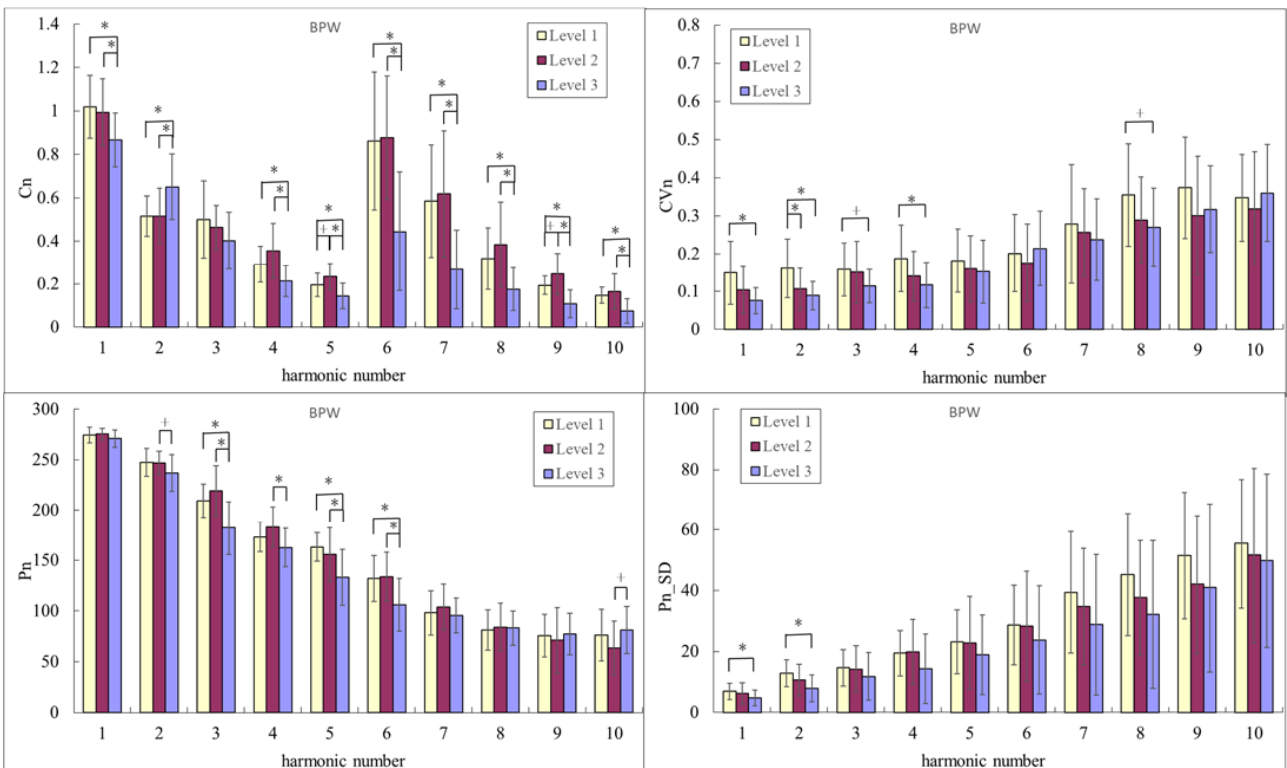
Figure 4. Comparisons of BPW harmonic indices between Level 3, Level 2, and Level 1: C n , CV n , P n , and P n _ SD . Data are mean and SD values. C 5 – C 10 values have been multiplied by 5 to make the di ff erences clearer. “*” indicates p < 0.05; “+” indicates 0.05 < p < 0.1. For C n values, C 2 was signi fi - cantly smaller in Level 2 and Level 1 than in Level 3, and C 1 and C 4 – C 10 were signi fi cantly larger in Level 2 and Level 1 than in Level 3. For P n values, most of P 3 – P 6 were signi fi cantly larger in Level 2 and Level 1 than in Level 3. For CV n values, CV 1 – CV 4 and CV 8 were signi fi cantly larger or appeared to be larger in Level 1 than in Level 3. For P n _SD values, P 1 _SD and P 2 _SD were signi fi cantly larger in Level 1 than in Level 3.